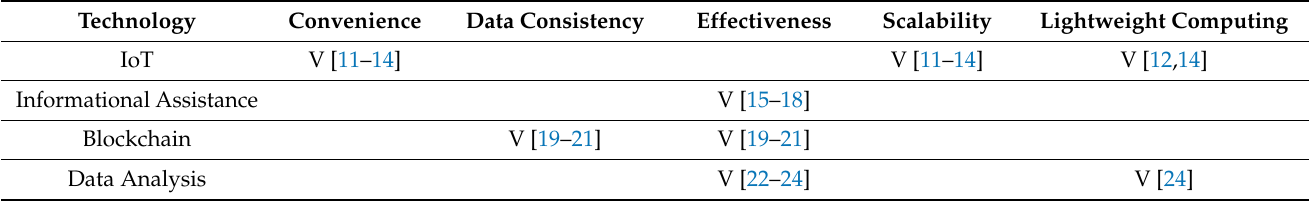
Table 1. The summary of the findings of the literature